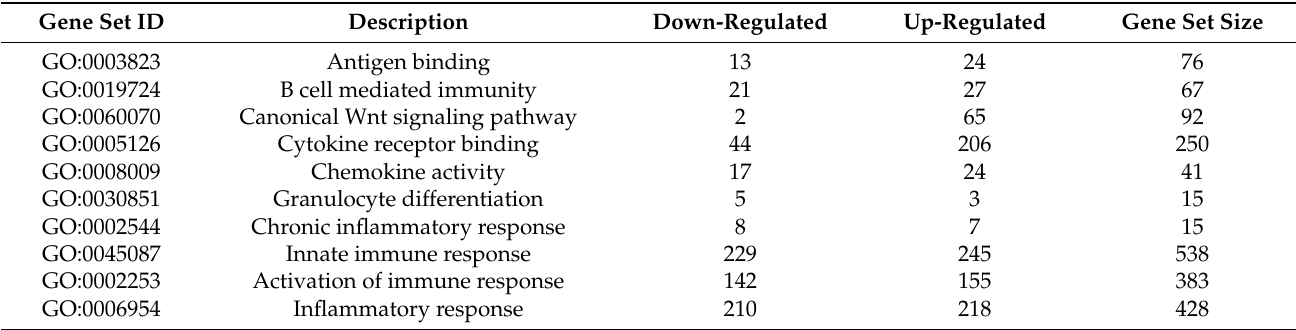
Table 1. Information about the target gene sets in this study, including the total number of genes in each set and the numbers of genes up-regulated or down-regulated in each target gene set. Gene Set